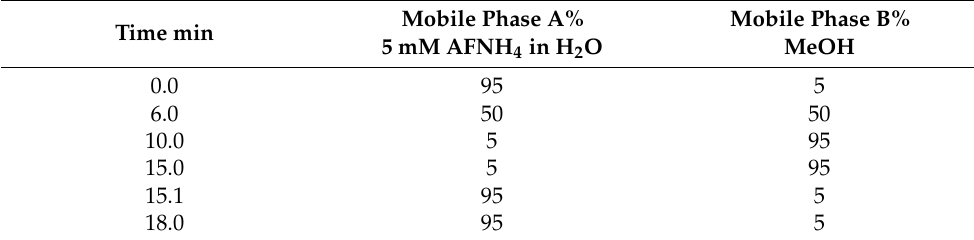
Table 5. The optimized elution gradient for chromatographic